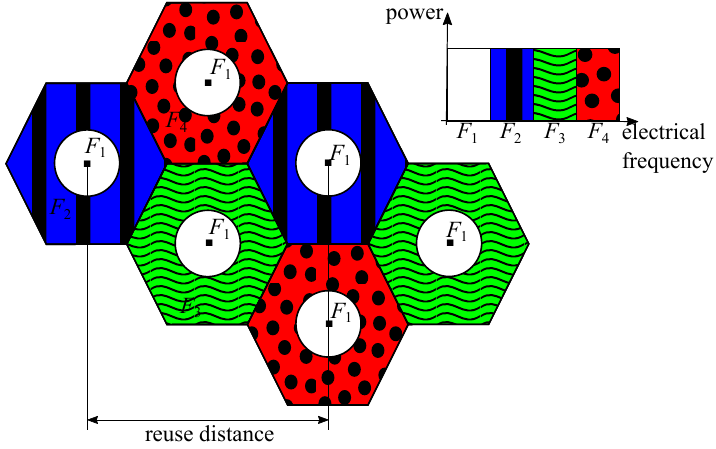
Figure 13. Example of